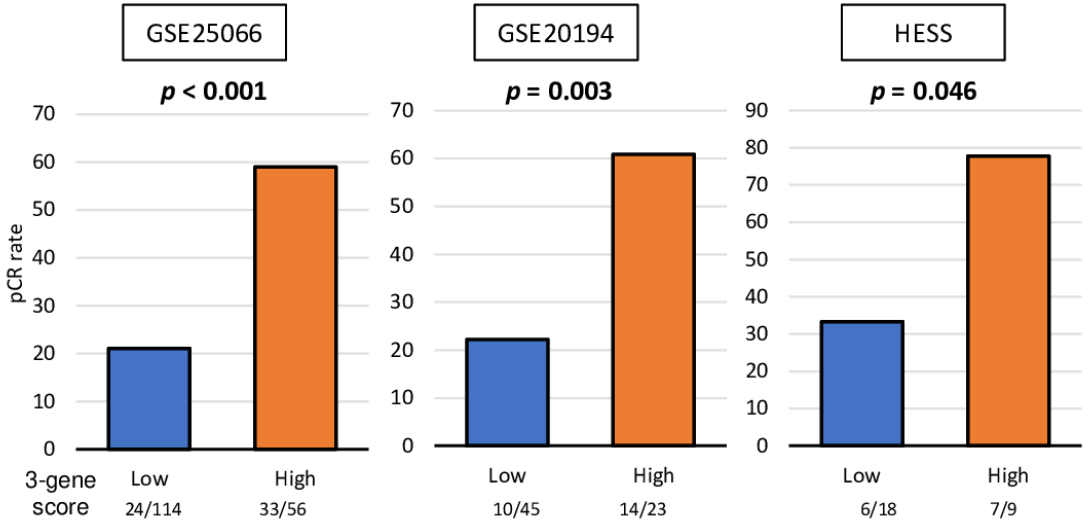
Figure 6. Association of the 3-gene score with drug response for TNBC cell lines and patients. Bar plots of the comparison of the pCR rate after NAC between the 3-gene score low (blue) and high (orange) groups in the GSE25066 ( n = 170), GSE20194 ( n = 68), and HESS ( n = 27) cohorts. Fisher’s exact test was used for the analysis. Group sizes are shown underneath the bar.